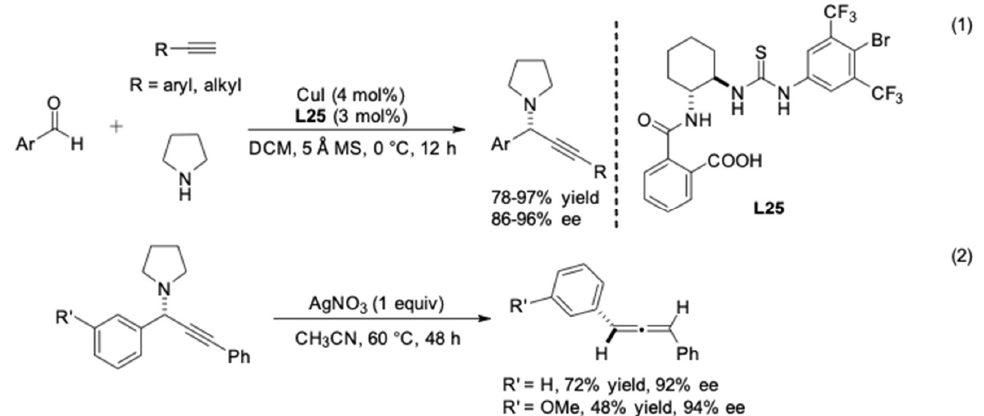
Figure 24. Enantioselective three-component reactions with thiourea and CuI.